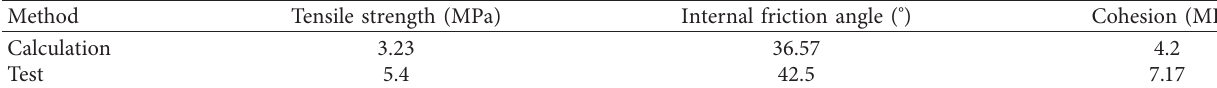
Table 2: Calculated value in the numerical modelling and test